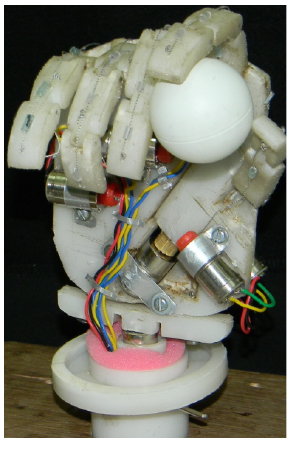
Figure 1. Ventral view of the Prototype